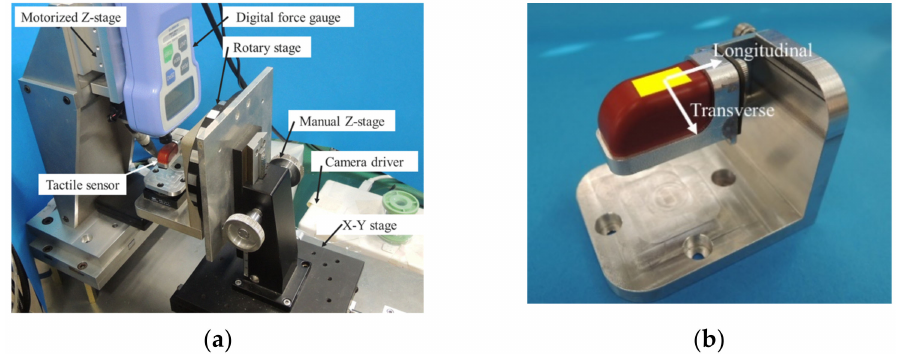
Figure 8. Loading apparatus: ( a ) structure of apparatus, which comprises manual xyz stages, a rotary stage, a motorized z-stage, a digital force gauge, a camera driver, and a tactile sensor; ( b ) tactile sensor mounted on a holder; sensing area and directions of applied force are indicated by the yellow square and arrows,